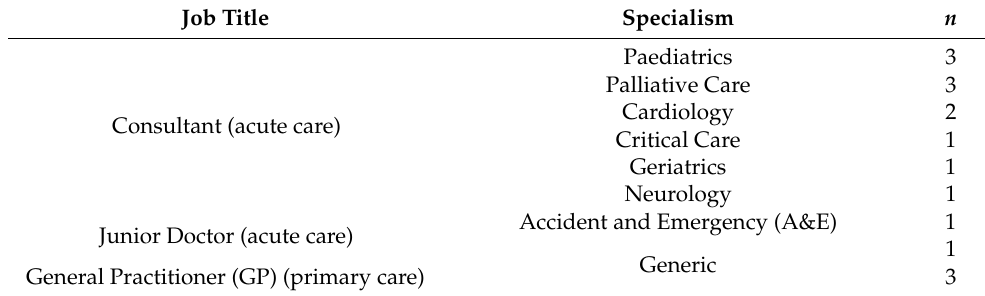
Table 1. Participant characteristics ( n =